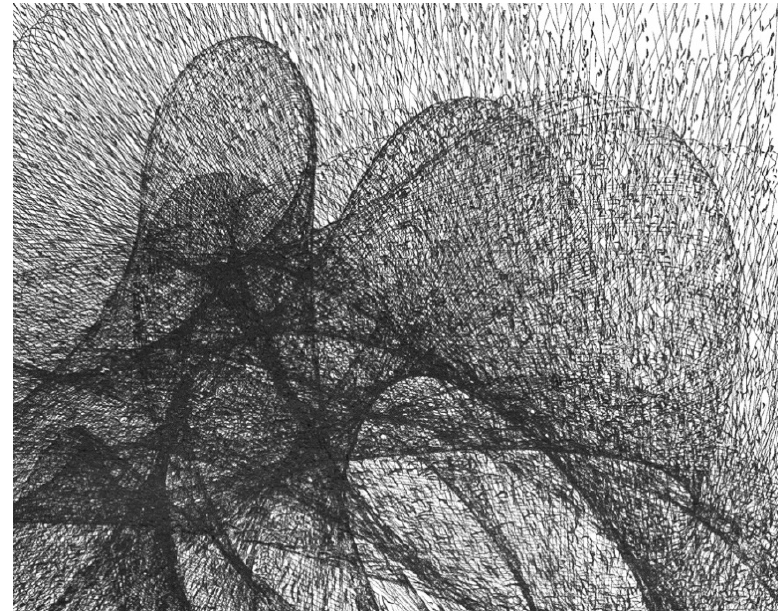
Figure 12. Close up detail of HHM.